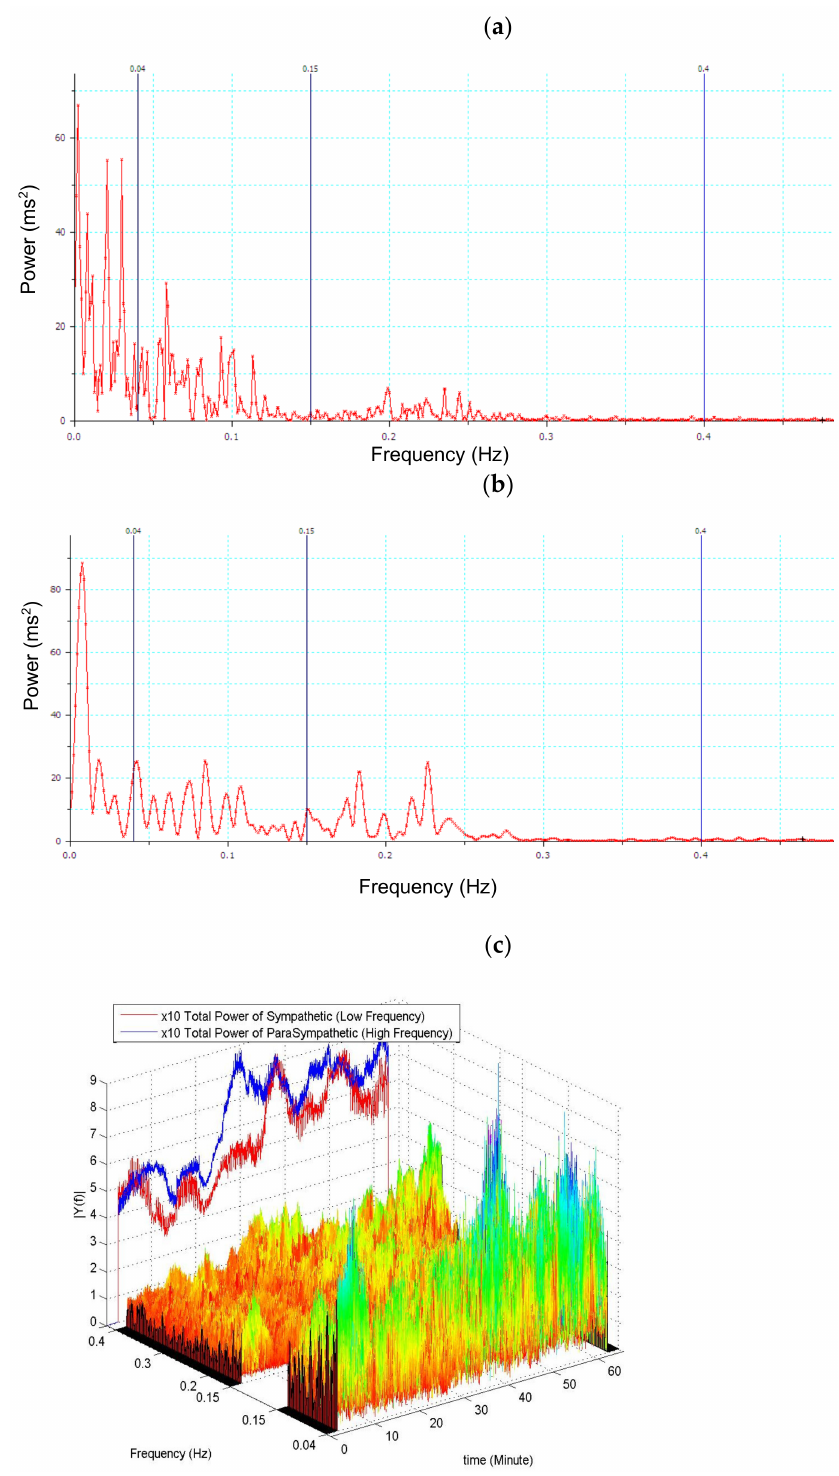
Figure 1. An example of spinal anesthesia R-R interval spectral analysis. ( a ) Without any premedica- tion, on the day of surgery, the patient lay in a supine position in a quiet room at least 5 min prior to preanesthetic baseline data collection. ( b ) Shifting of power by R-R interval spectral analysis 30 min after spinal anesthesia. ( c ) The sliding window of 60 s shows the shifting power of LF and HF after spinal